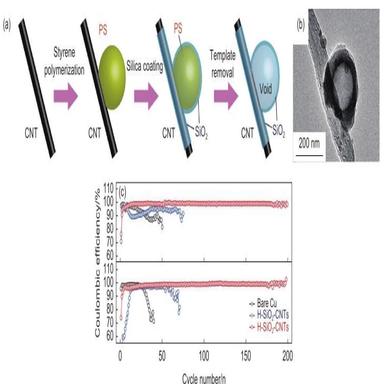
a) Synthetic approach. (b) TEM image, and (c) Coulombic efficiencies of the H-SiO2/CNTs at different current densities (0.2 and 0.5 mA cm−2 , respectively). Reproduced by permission of American Chemical Society